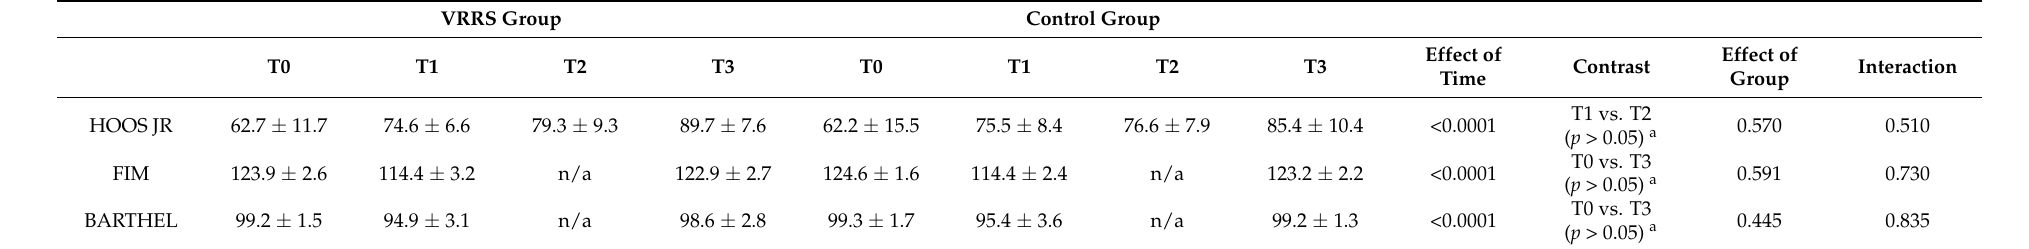
Table 3. Between and within-group comparisons (VRRS and control groups) at different time points (T0, T1, T2, and T3), Data are reported as means ± standard deviations. HOOS JR: Hip Dysfunction and Osteoarthritis Outcome Score for Joint Replacement (0–100); FIM: Functional Independence Measure (18–126);